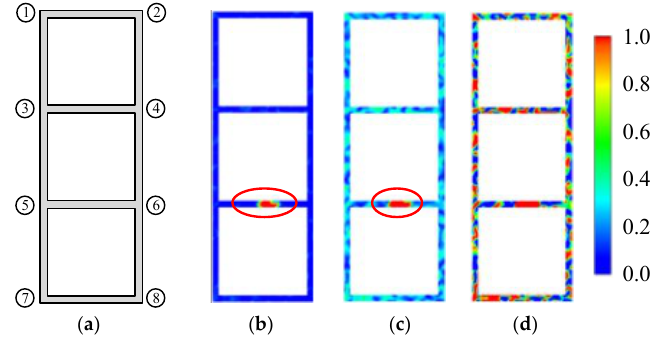
Figure 9. The model and imaging results of 3 × 1 block with different number of measurements. ( a ) Block model; ( b ) 8 nodes; ( c ) 6 nodes; ( d ) 4 nodes.